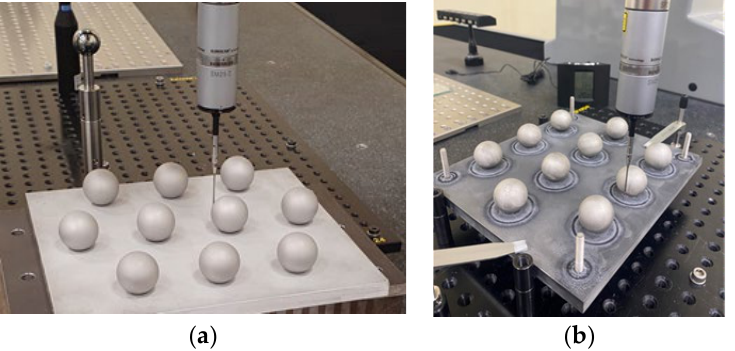
Figure 6. ( a ) Surface finish after sandblasting (previous research). ( b ) Surface finish after chemical treatment with aqua regia.